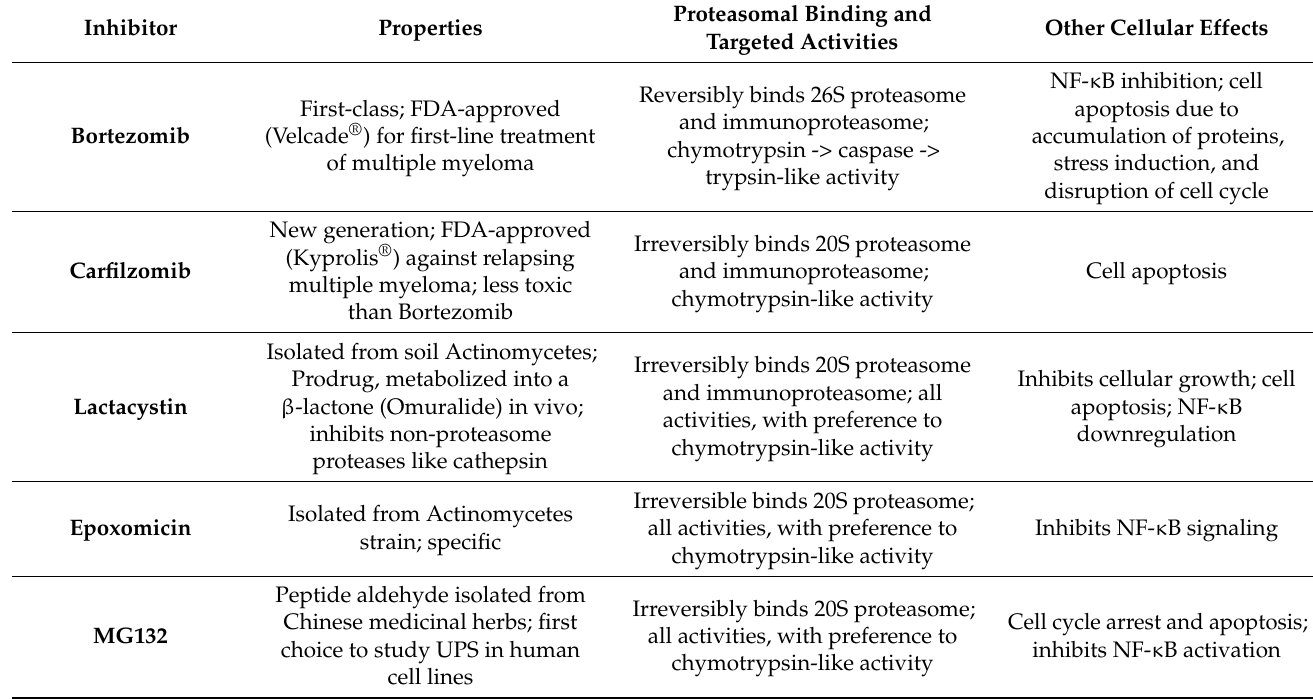
Table 1. Some proteasome antagonists and their